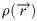
Cell-based model of neural crest—placode interactions.(A-E) Illustration of cellular behaviors in the model: polarized cell motility (A), co-attraction (CoA, B) and contact inhibition of locomotion (CIL, C) between NC-NC cells, and chase and run behavior (D-E) based on Sdf1 chemotaxis (D) and repulsion (E) between NC-placode cells. (F-G) Example simulation of the model, showing initial (E) and final (F) cell configurations with NC (orange) and placodal (red) cells. AP and DV axes indicate axes analogous to anterior-posterior and dorso-ventral directions in embryos. (H) Outline of the simulated NC population at t = 300,600,1200,2100, and 3600 MCS. (I) Inhibitor concentration levels at the end of the simulation mimicking the pattern of inhibitors in vivo. (J) NC cell density probability function related to pair-correlation of cells. Color indicates ρ(r⃗) value, brightness shows number of samples (N) at position r⃗ in summation (Eq 1); averaged from n = 20 independent simulation repeats. (K-L) Sections of ρ(r⃗) function shown in (J) along the AP (K) and DV (L) axes. W and L indicate the characteristic width and length. (M) Time evolution of W, L, and the aspect ratio L/W. (N) Average concentration levels in the simulation area. Error bars indicate SEM; n = 20 simulations; a.u.: arbitrary unit; s.u.: simulation unit of one lattice site, the minimal simulated distance; MCS: Monte Carlo time step.